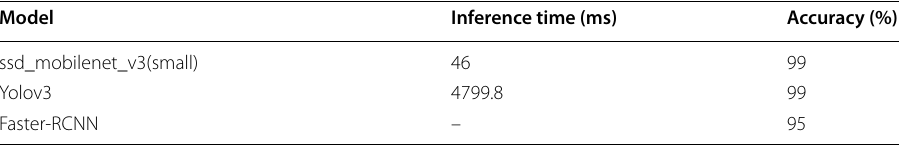
Table 2 Comparison of inference time and accuracy of different models